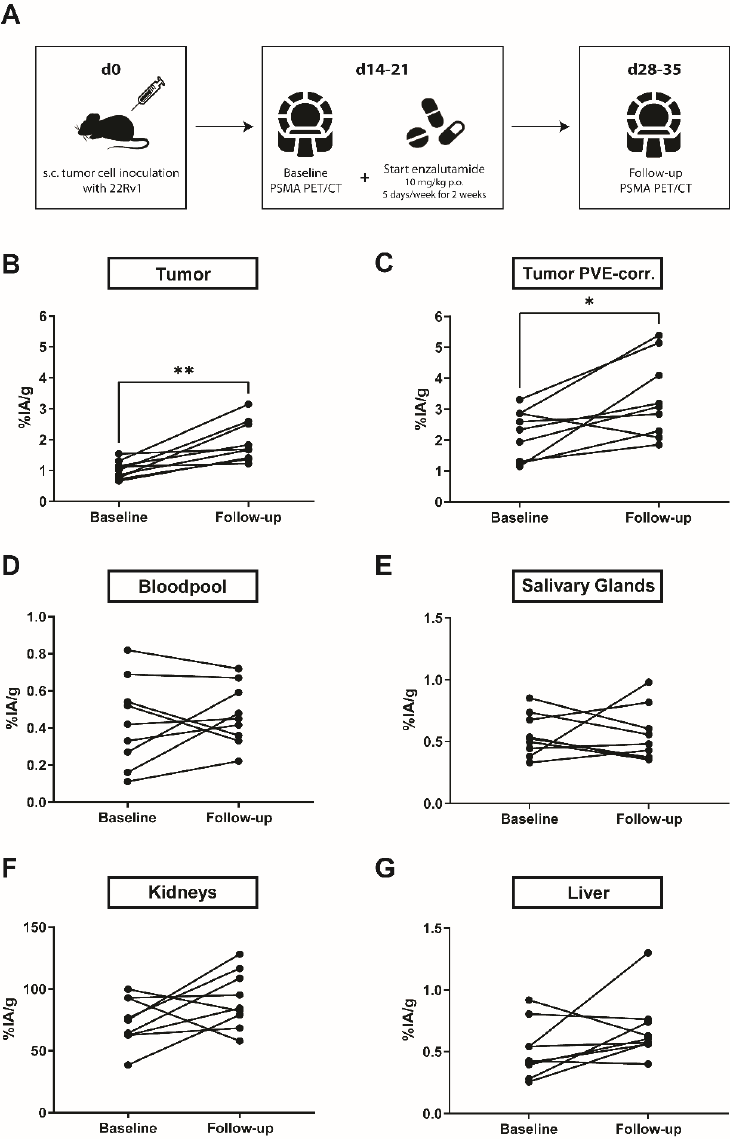
Figure 3. In vivo PSMA levels before and after treatment with enzalutamide by PET/CT. ( A ) 22Rv1 tumor cells were injected into the shoulder region of male, 6 – 10-week-old NOD/Scid mice. As soon as tumors were palpable (approx. 2 – 3 weeks after inoculation), baseline 68 Ga-PSMA-11 PET/CT was performed and enzalutamide treatment (10 mg/kg daily by oral gavage (p.o.), 5 days a week for 2 weeks) was started. After 2 weeks of enzalutamide, follow-up 68 Ga-PSMA-11 PET/CT was performed. ( B ) 68 Ga-PSMA uptake per gram tissue in 22Rv1 tumors increased significantly after two weeks of treatment with enzalutamide. PVE-corrected tumor size before and after enzalutamide is shown in ( C ). Measurements of bloodpool ( D ), salivary glands ( E ), kidneys ( F ) and liver ( G ) served as controls and did not show a significant change in 68 Ga-PSMA uptake. Abbreviations: %IA/g, % injected activity per gram tissue. Statistics: Wilcoxon matched-pairs signed-rank test. * p ≤ 0.05, ** p ≤